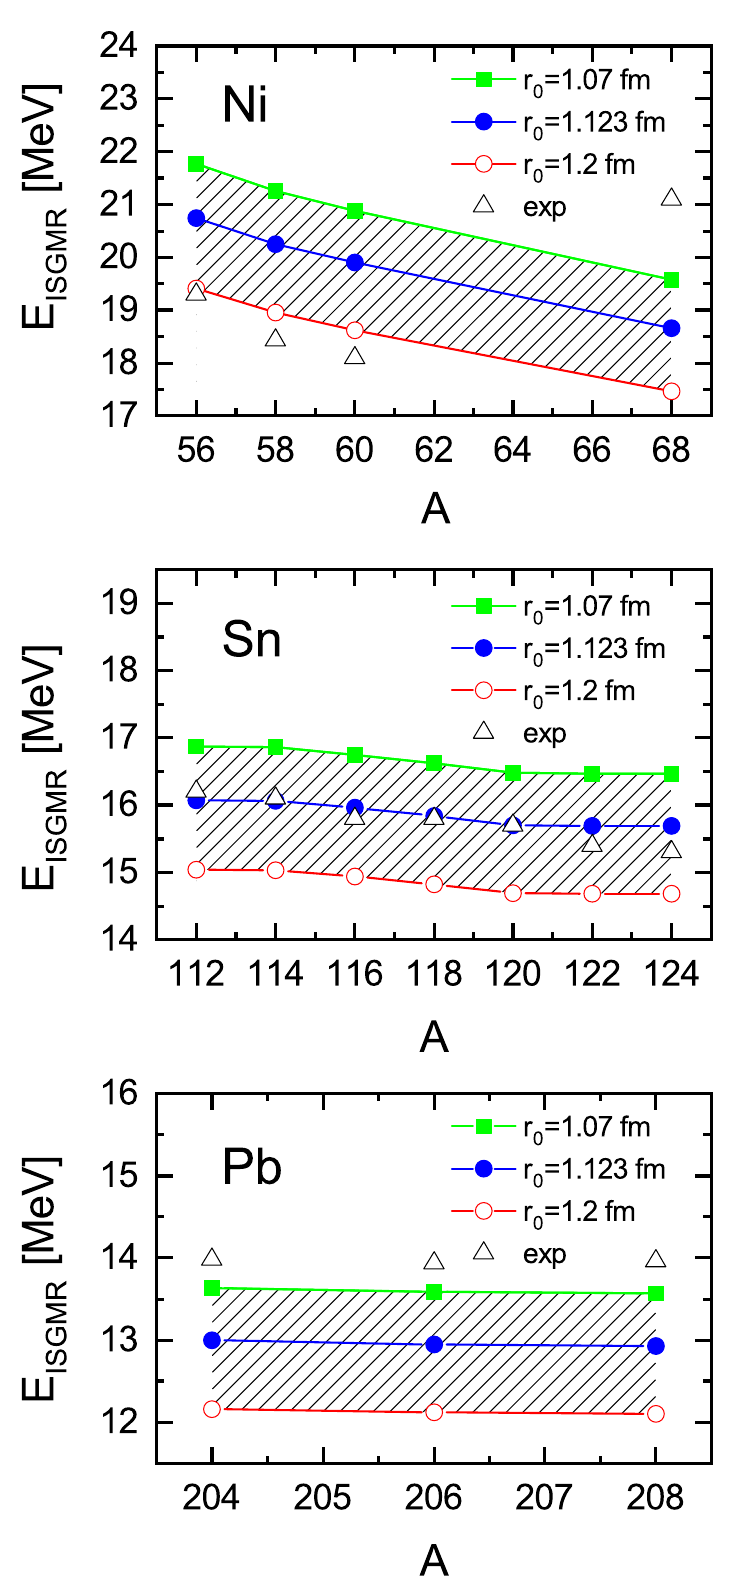
Figure 3. The centroid energies E ISGMR as a function of the mass number A for Ni, Sn, and Pb isotopes in the case of SLy4 force obtained with three different values of the parameter r 0 = 1.07,1.123,1.2 fm (Equation (1)) compared with the experimental